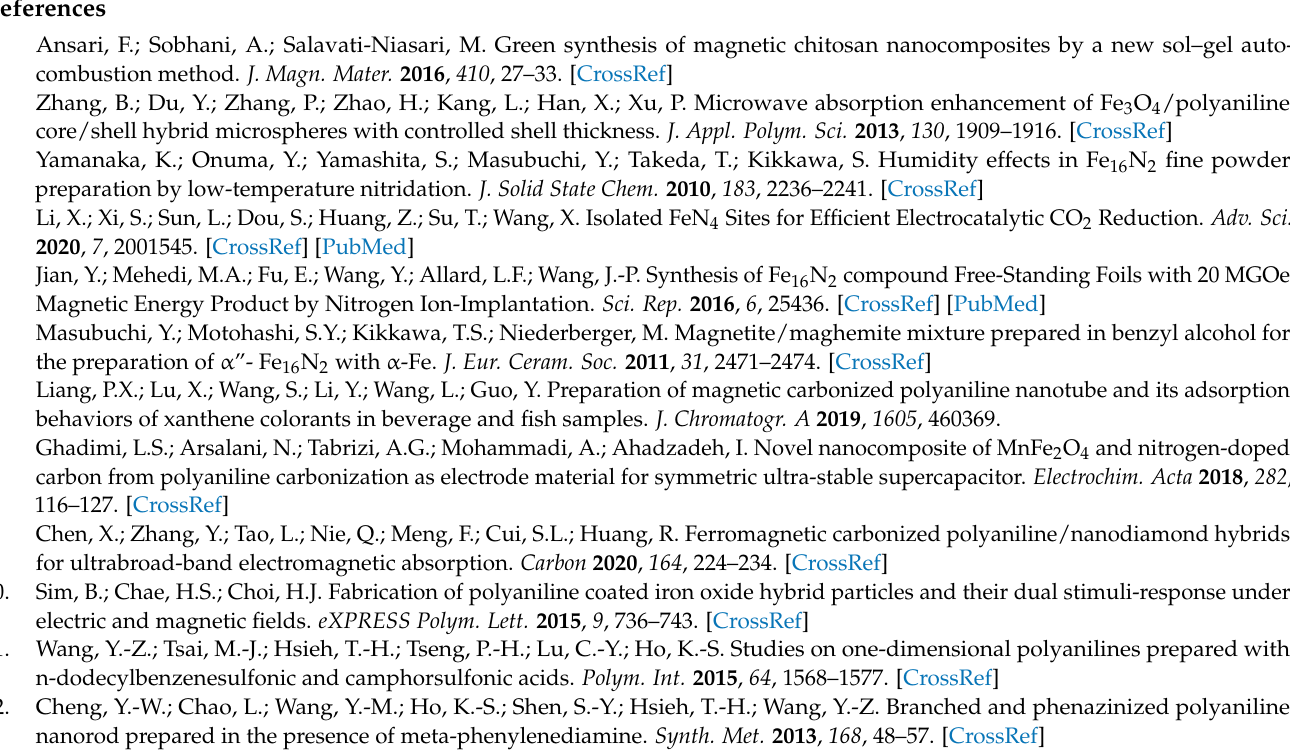
shown in Figure 9c (down inset diagram of Figure